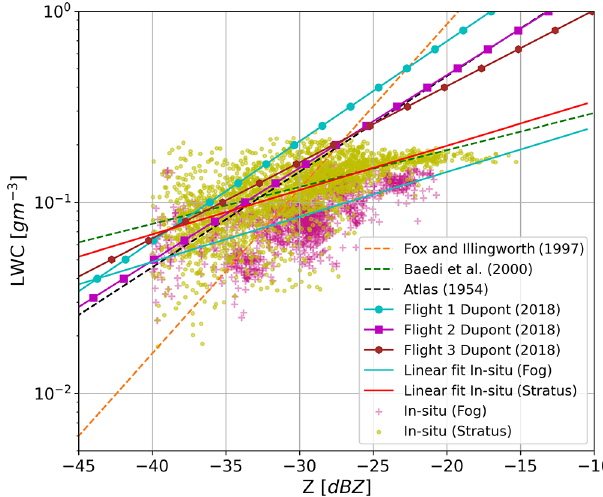
Figure 10. Scatterplot for the relation between LWC measured from CDP with radar reflectivity from cloud radar, compared with the available literature. In situ measurements are separated for fog and stratus clouds where magenta denotes fog, yellow–green (chartreuse) denotes the stratus cloud, and the respective linear fits are also